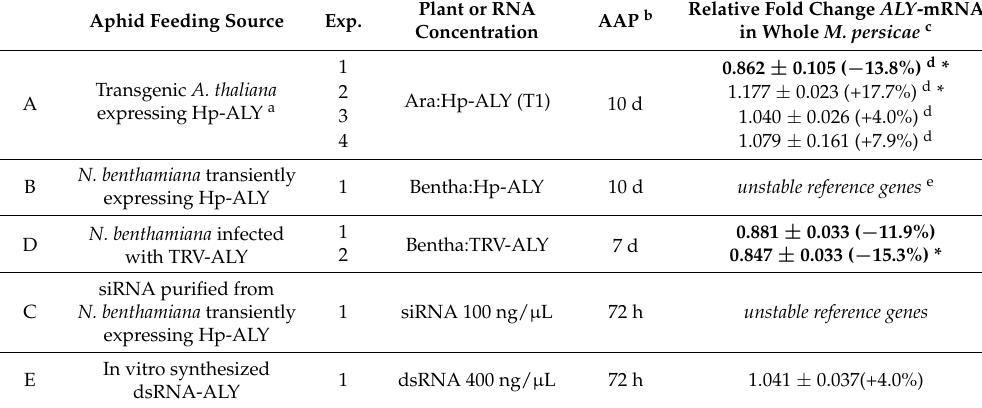
Table 3. Silencing efficiency of ALY in whole M. persicae using different RNAi-based methods. Aphid Feeding Source Exp.